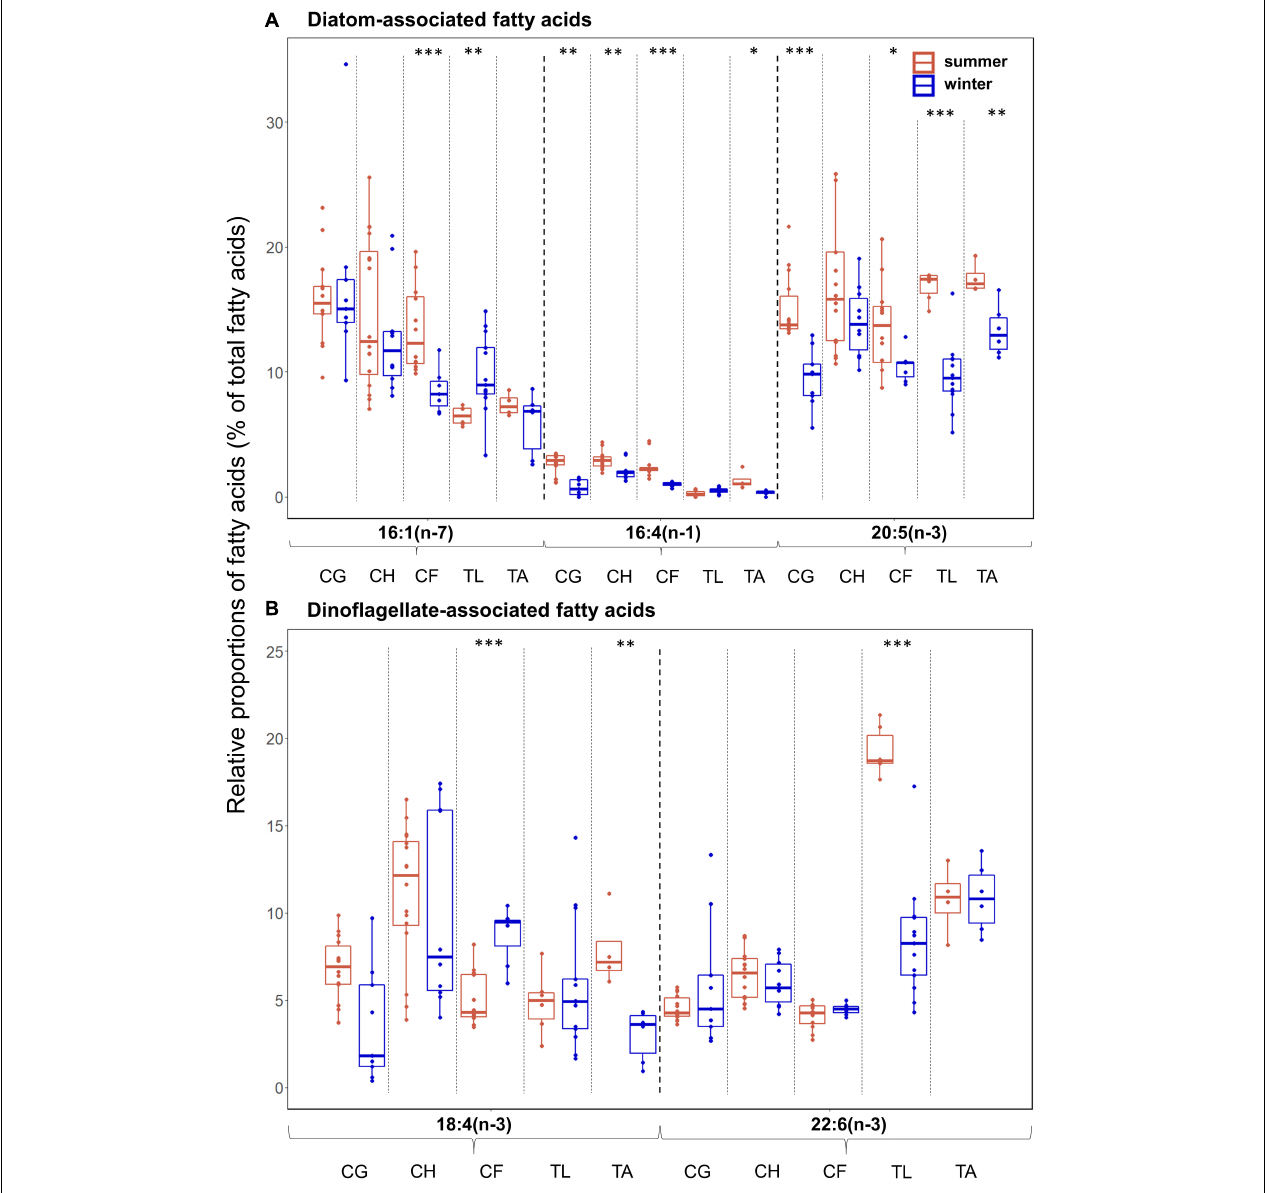
FIGURE 4 | Relative proportions (as % of total fatty acids-FAs) of (A) diatom- [16:1(n-7), 16:4(n-1), 20:5(n-3)] and (B) dinoflagellate-associated marker FAs [18:4(n-3), 22:6(n-3)] during summer (Q3) and winter (Q4) in the copepods Calanus glacialis (CG; Q3: n = 14, Q4: n = 9), C. hyperboreus (CH; Q3: n = 16, Q4: n = 10) and C. finmarchicus (CF; Q3: n = 12, Q4: n = 7) and the amphipods Themisto libellula (TL; Q3: n = 6, Q4: n = 13) and T. abyssorum (TA; Q3: n = 4, Q4: n = 6). Box plot design is described in Figure 2